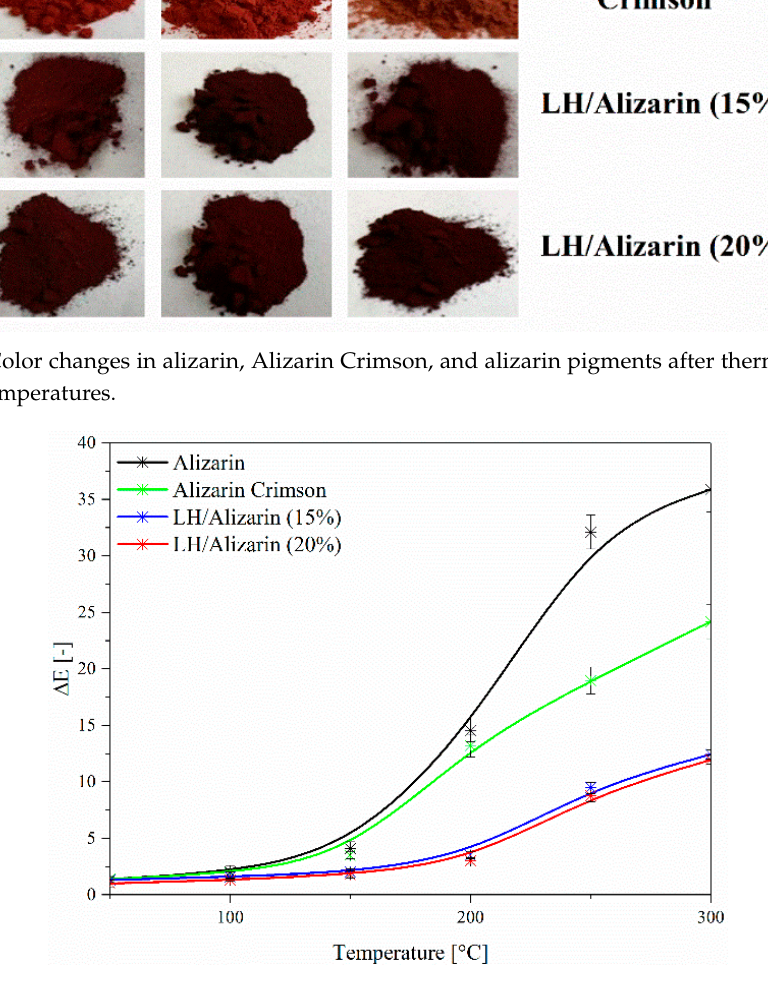
Figure 8. Color changes in alizarin, Alizarin Crimson, and alizarin pigments after thermal aging at different temperatures.